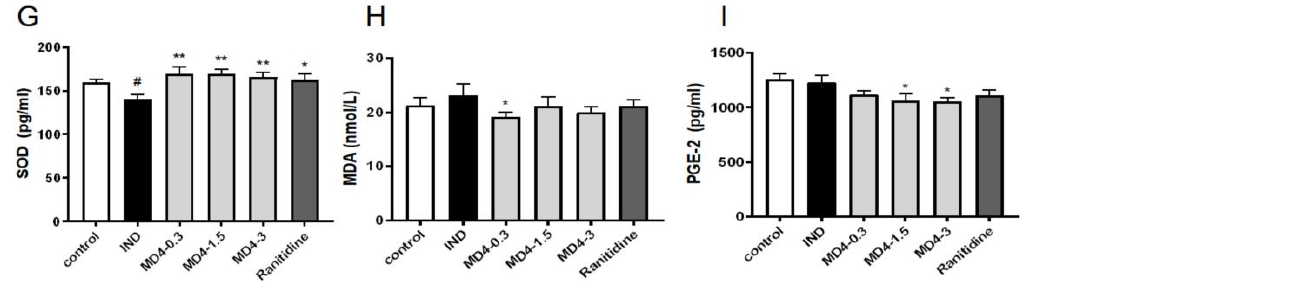
Figure 1. ( A , B ): Histopathological features after MD-4 treatment on IND-induced gastric ulcers in rats. In the IND group, rats showed severe injury and inflammation of the gastric epithelium and edema of submucosa. MD-4 improved these alterations dose-dependently and showed less mucosal damage and milder inflammation in contrast to the IND group. IND: indomethacin; MD-4: molor dabos-4 decoction. ( C ): Ulcer index. Data are reported as means ± SEM ( n = 6). ** p < 0.01 vs. IND group; *** p < 0.001 vs. IND group. ( D – I ): Levels of TNF- α , IL-6 and pepsin in serum and SOD, MDA and PGE-2 in gastric tissues. Data are expressed as means ± SEM ( n = 6). # p < 0.05 vs. control group; ## p < 0.01 vs. control group; * p < 0.05 vs. IND group; ** p < 0.01 vs. IND group; *** p < 0.001 vs. IND group.